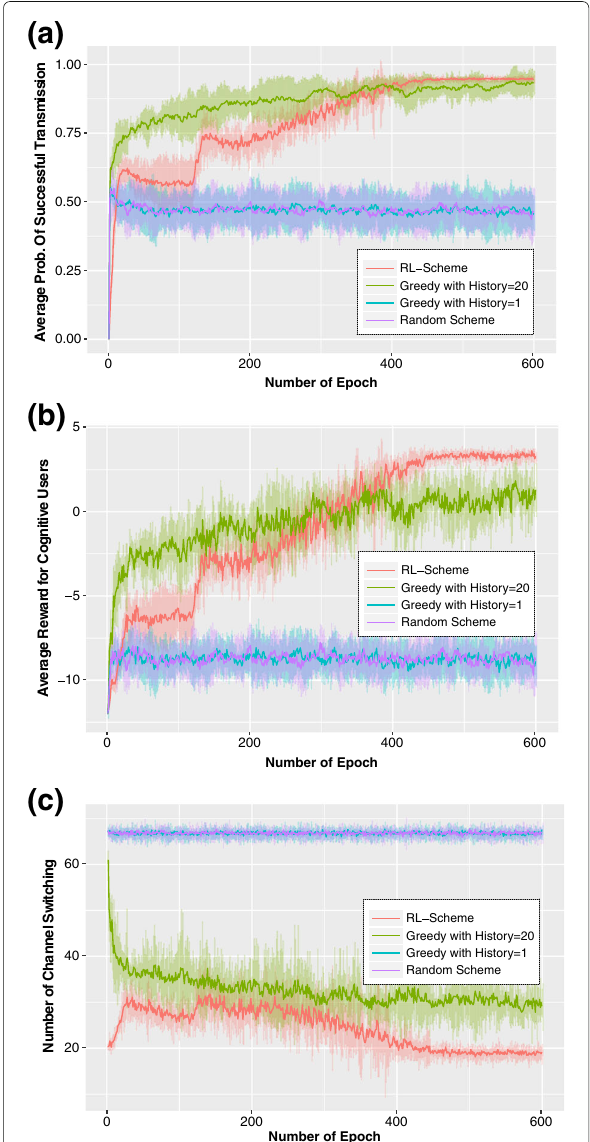
Fig. 6 Performance evaluation of RL-based scheme. a Average probability of successful transmission. b Average reward of CR users. c Average number of channel